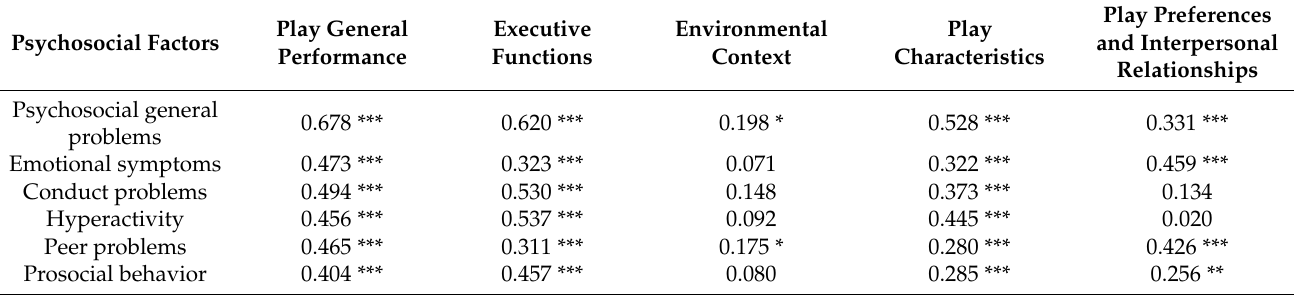
Table 2. Correlations between play and psychosocial factors ( n = 142).